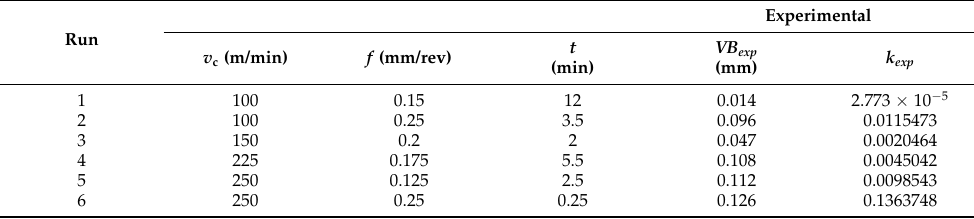
Table 4. Experimental and prediction values of coefficient k .